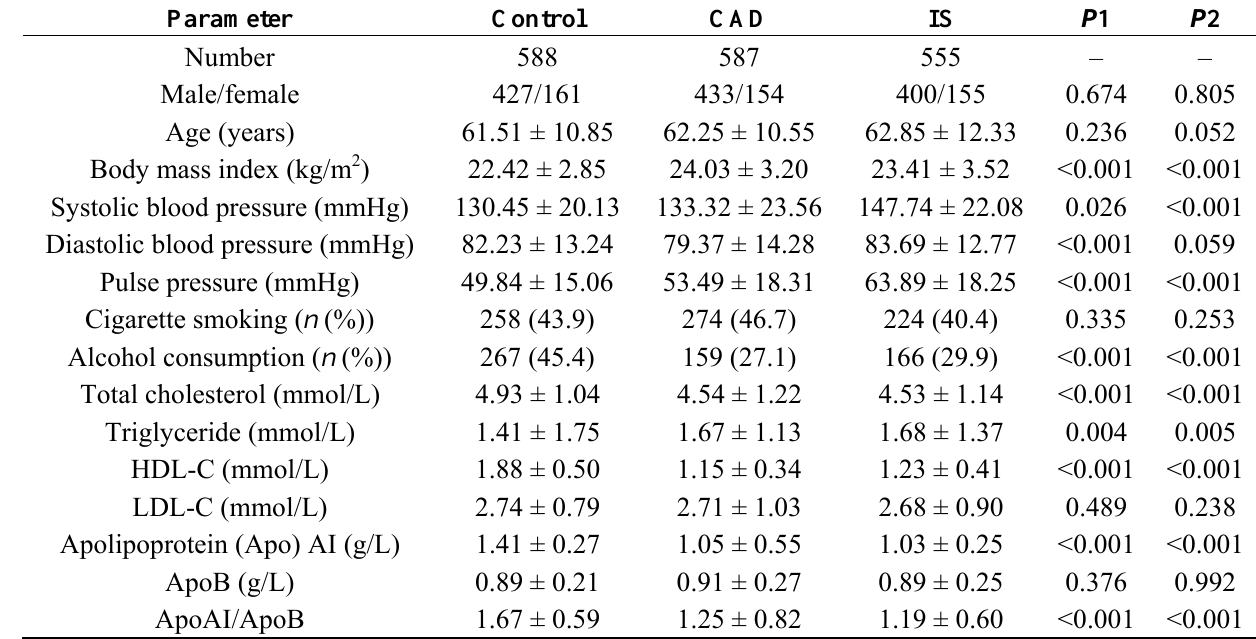
Table 1. General characteristics and serum lipid levels in the controls and patients. Parameter Control CAD IS P